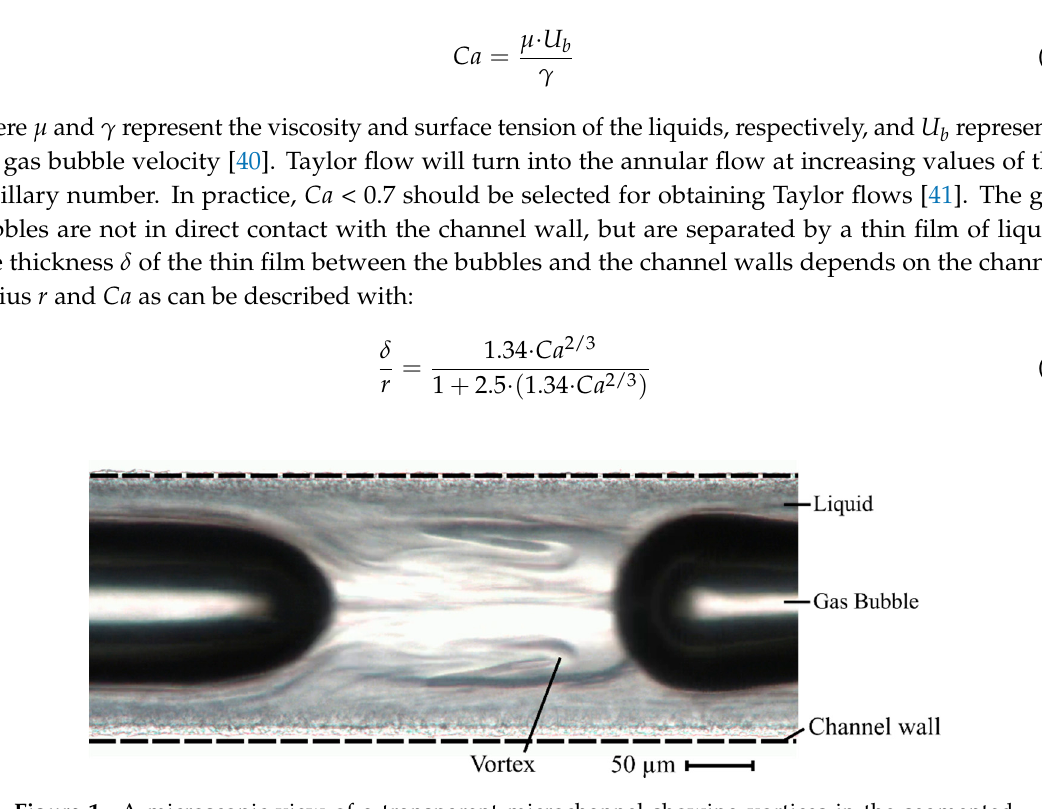
Figure 1. A microscopic view of a transparent microchannel showing vortices in the segmented gas–liquid flow. The wall friction in the channel causes a relative backflow of the liquid so that it circulates symmetrically around the central axes of the channel in the form of vortices. The bubble diameter is lower than the channel diameter (dashed lines indicate channel wall positions) by the amount of 2 δ